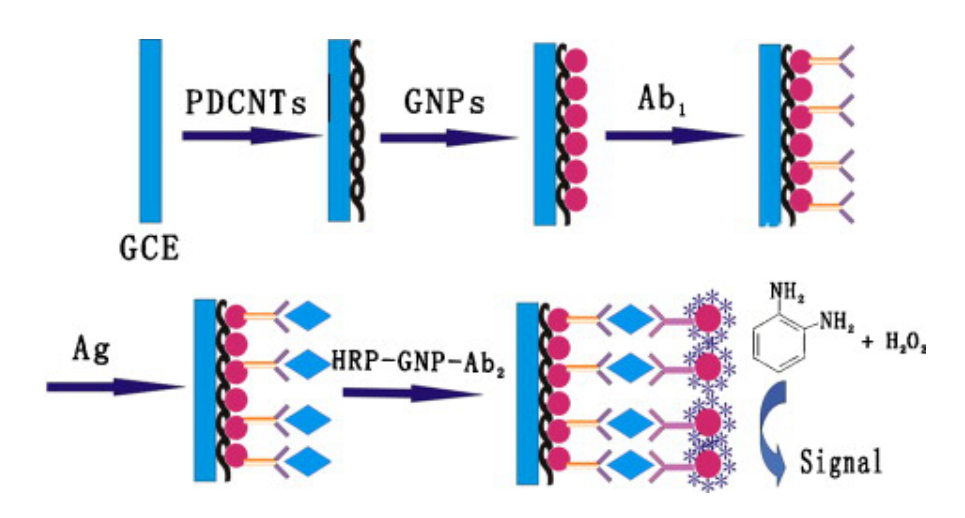
Figure 3. The immunoassay procedure of GNPs/PDCNTs modified immunosensor